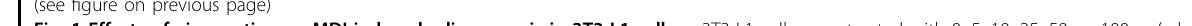
Fig. 1 Effects of vinpocetine on MDI-induced adipogenesis in 3T3-L1 cells. a 3T3-L1 cells were treated with 0, 5, 10, 25, 50, or 100 μ g/ml vinpocetine at 2 days after MDI treatment. Then, Oil Red O staining was performed on day 6 as described in the “ Materials and methods ” , and images were acquired by microscopy. b Vinpocetine was administered to 3T3-L1 cells at a range of doses, and cell lysates were harvested at 0 and 6 days after inducing differentiation. Protein expression of PPAR γ , C/EBP α , C/EBP β , and downstream factors, such as FABP4 and fatty acid synthase in 3T3-L1 cells was detected by western blotting. β -actin was used as a load control. c Cytotoxicity in 3T3-L1 preadipocytes treated with up to 100 μ g/ml vinpocetine was measured by MTT assay ( n = 3 for each lane). d 3T3-L1 cells were treated with vinpocetine at 50 or 100 μ g/ml, and Oil Red O staining was performed as described in the “ Materials and methods ” . Cells were differentiated for 6 days. e Lipid accumulation in 3T3-L1 cells was measured using spectrophotometry as described in the “ Materials and methods ” ( n = 3 for each lane). f , g 3T3-L1 cells were treated with 50 or 100 μ g/ml vinpocetine at 2 days after MDI treatment, and cell lysates were harvested at days 0, 2, 4, and 6 after inducing the differentiation of the cells. The mRNA expression levels of the genes encoding adipogenesis-associated factors, such as PPAR γ , C/EBP α , and C/EBP β , and downstream factors, such as FABP4 and fatty acid synthase, were detected by RT-PCR analysis. The protein expression of adipogenesis-associated factors and downstream factors was detected by western blotting. β -actin was used as a load control. Data are presented as the mean ± standard error of the mean (SD); ns = not signi fi cant; ** P < 0.01 for untreated control vs. 50 and 100 μ g/ml